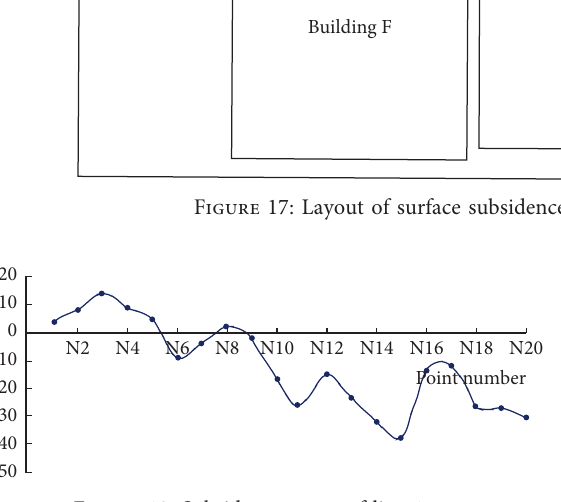
Figure 18: Subsidence curve of line 1.